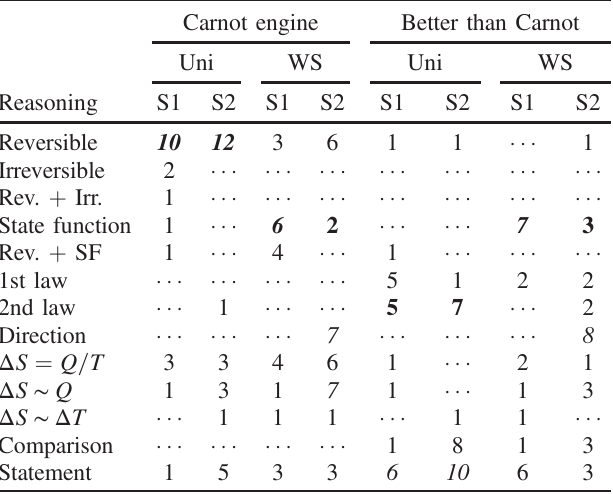
TABLE II. Response frequencies. EEQ pretest reasoning for school 1 (S1) and school 2 (S2). The “ Uni ” columns refer to questions regarding the change in entropy of the universe, and the “ WS ” columns refer to questions regarding the change in entropy of the working substance. The correct reasoning is shown in bold for each subquestion; the most common reasoning for each population is italicized.